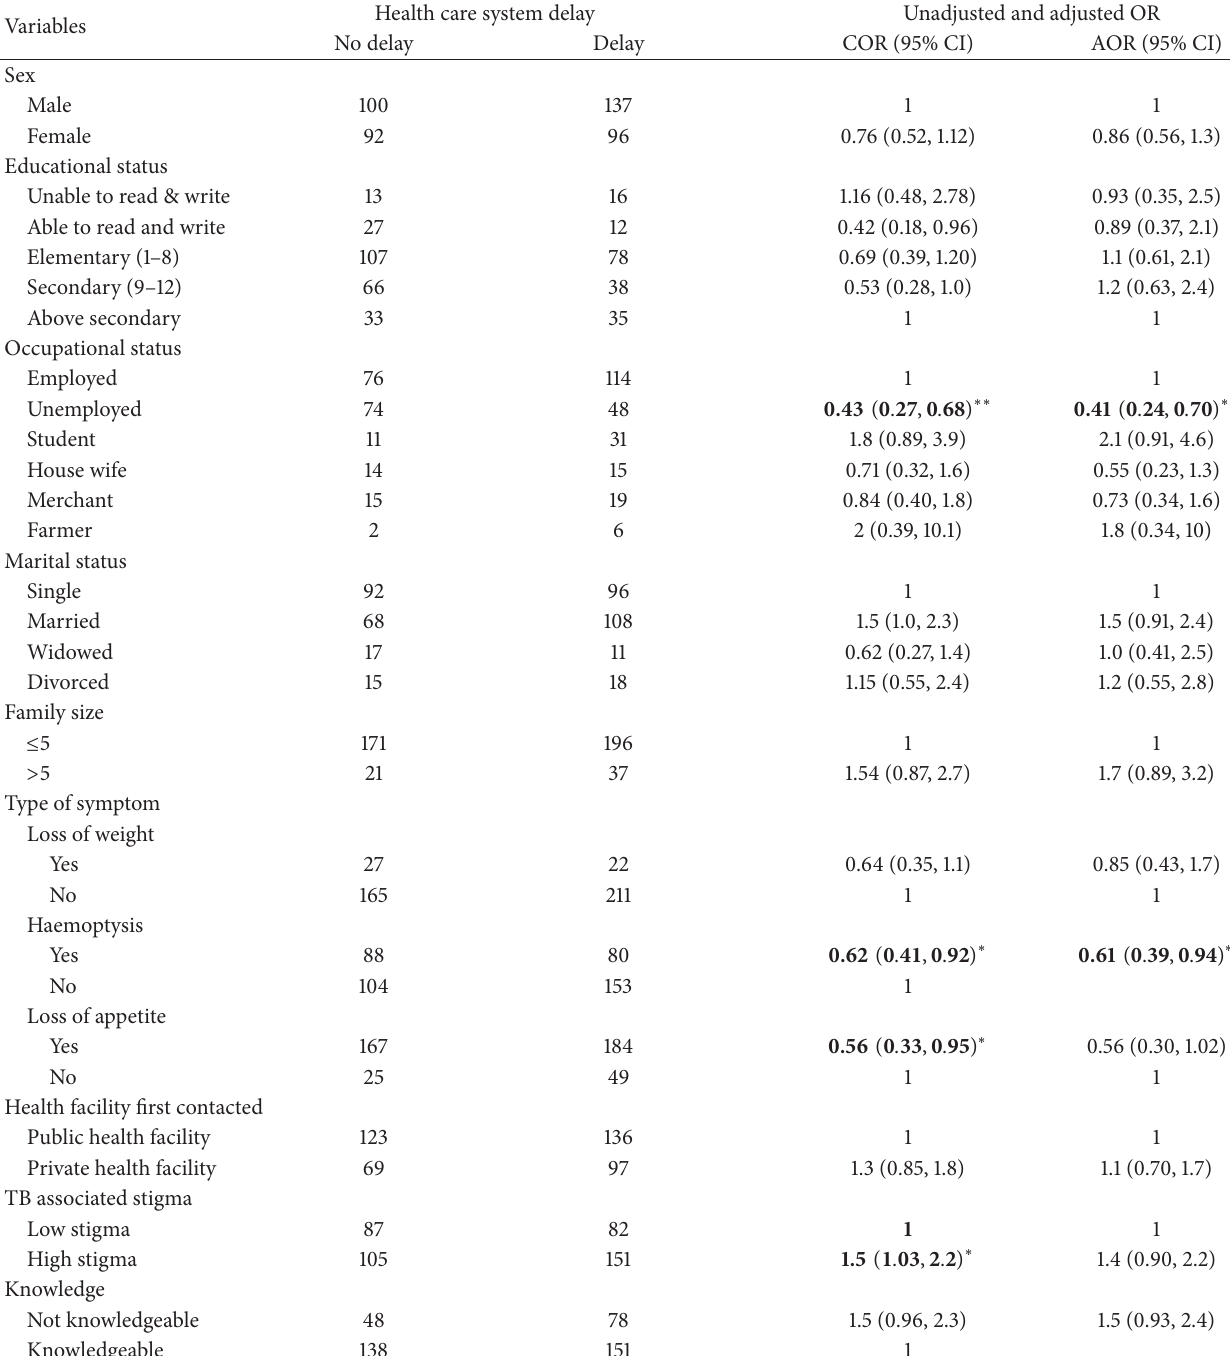
Table 4: Factors associated with health care system delay for treatment of pulmonary TB among pulmonary TB patients, Addis Ababa, Ethiopia,